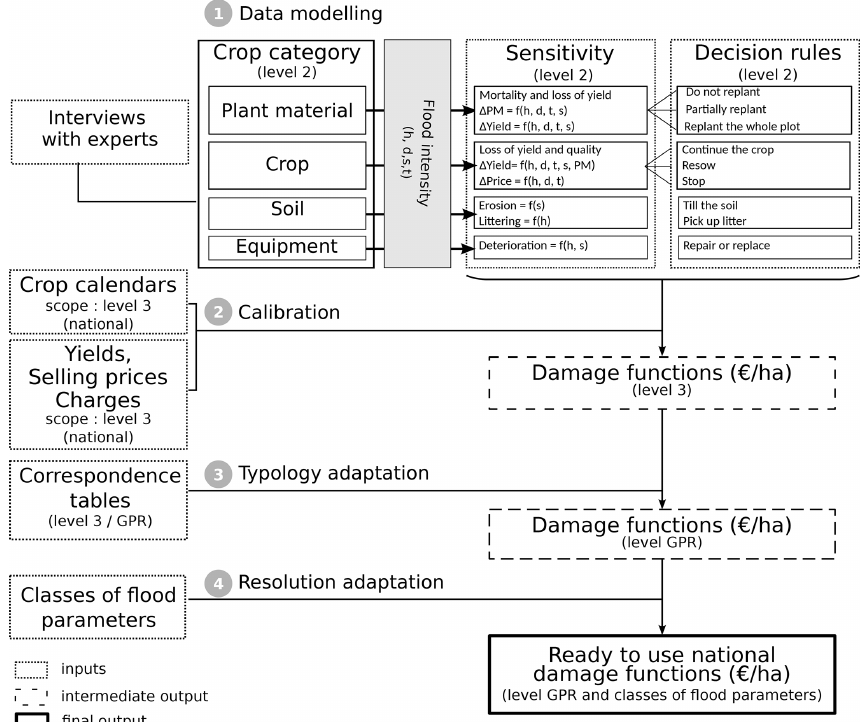
Figure 3. Production process of the national French flood damage functions with